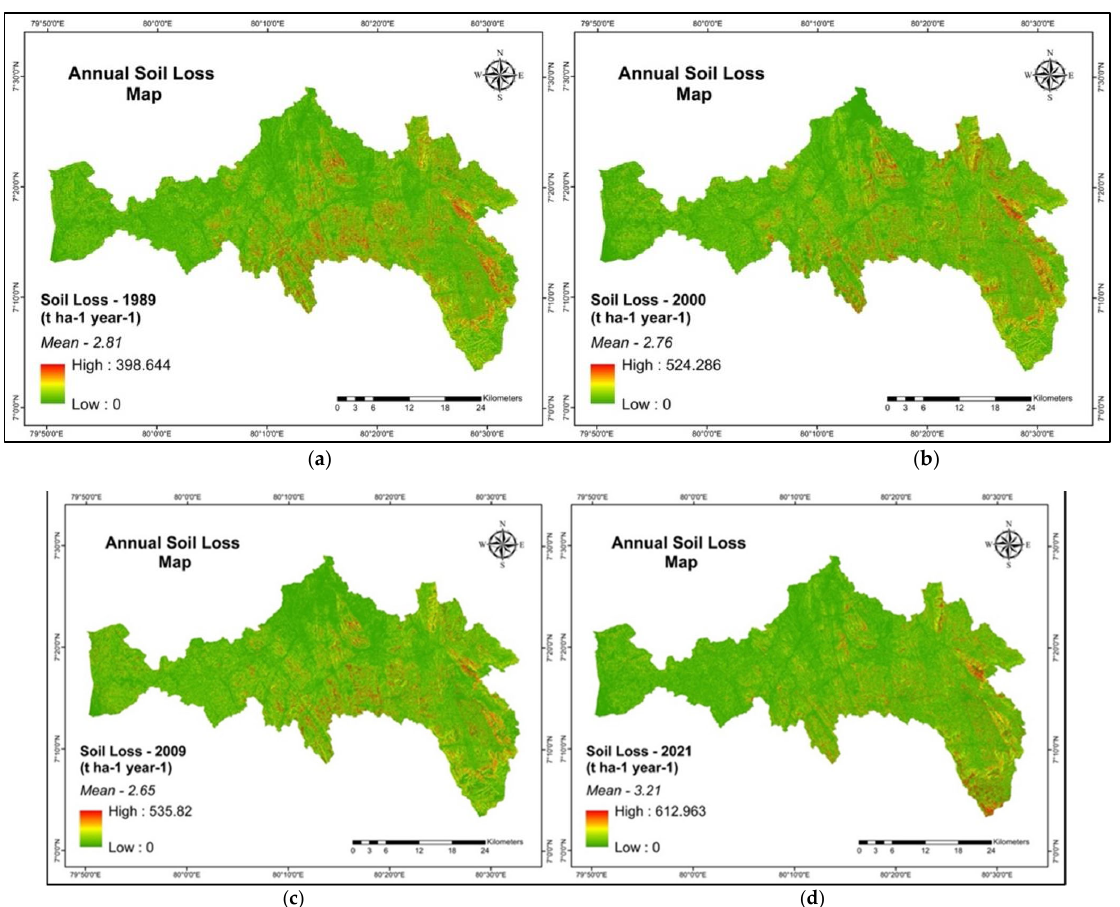
Figure 10. Average annual soil loss maps of MORB for ( a ) 1989, ( b ) 2000, ( c ) 2009, and ( d ) 2021. According to Figure 10, the average annual soil loss rate of the MORB ranged between 0 to 612.96 t ha − 1 yr − 1 . In 1989, the soil loss rate varies from 0 to 398.644 t ha − 1 yr − 1 with a mean erosion rate of 2.81 t ha − 1 yr − 1 , while years 2000, 2009, and 2021 had the mean average annual soil erosion rates of 2.76 t ha − 1 yr − 1 , 2.65 t ha − 1 yr − 1 , and 3.21 t ha − 1 yr − 1 , respectively. Thus, the soil erosion rate considerably increased from the year 1989 to 2021.